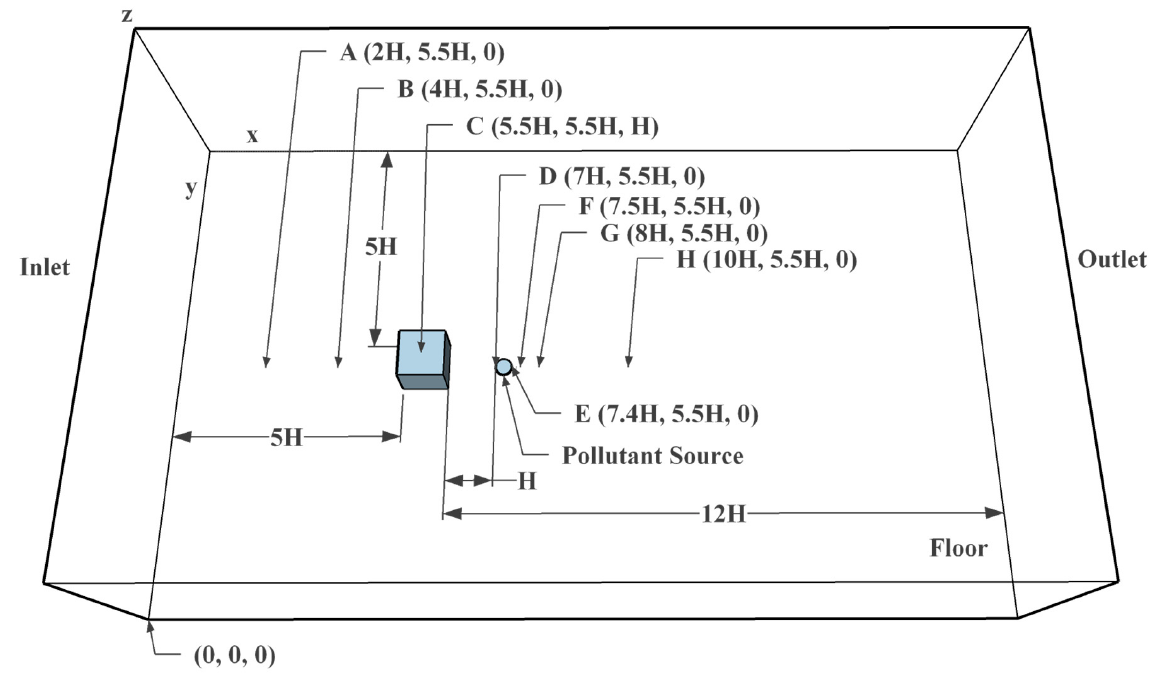
Figure 1. Computational domain and boundary conditions.